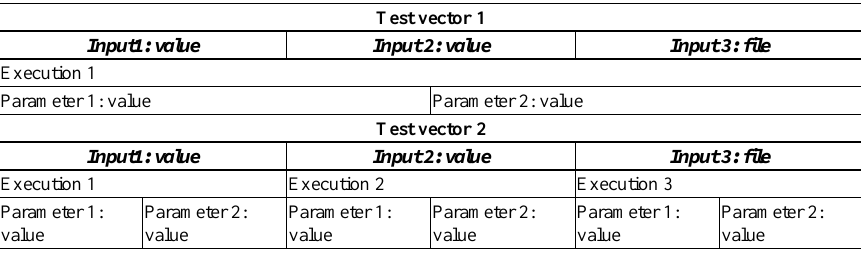
Table 2. Example structure of test vectors and execution